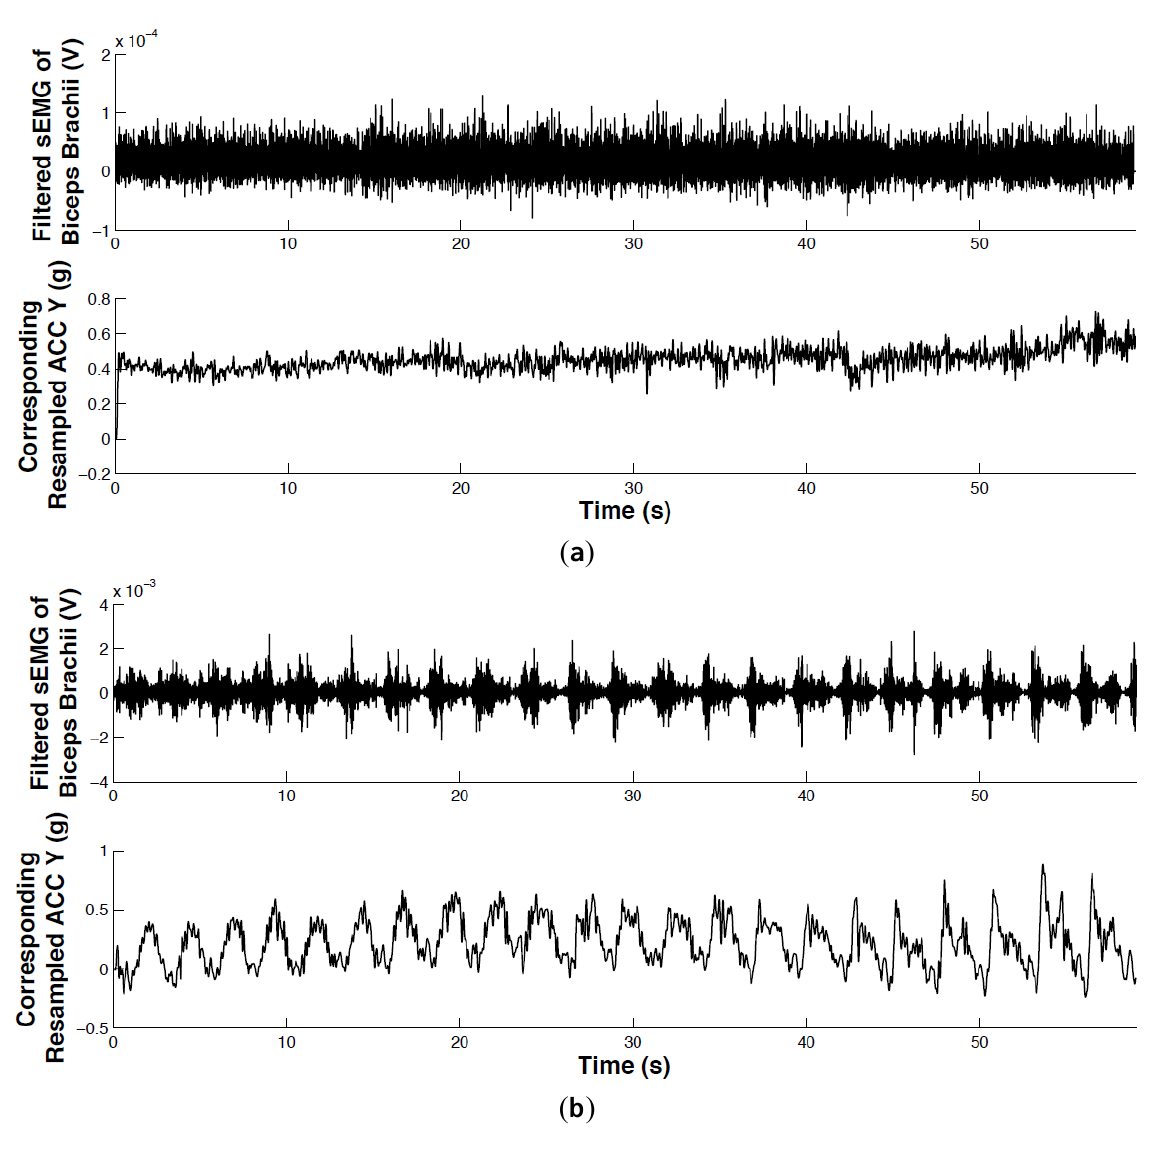
Figure 6. Pre-processed measurements. Filtered sEMG signal of biceps brachii and corresponding resampled rotational acceleration signal in Experiment 1 ( a ) and Experiment 2 ( b ). The movement in Experiment 1 is non-periodic, whereas the movement in Experiment 2 is